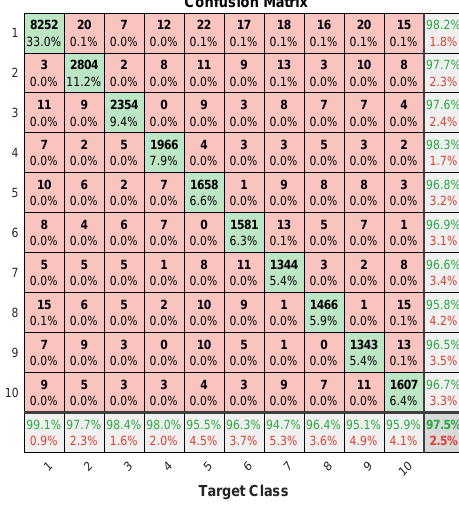
Figure 14. The confusion matrix for test